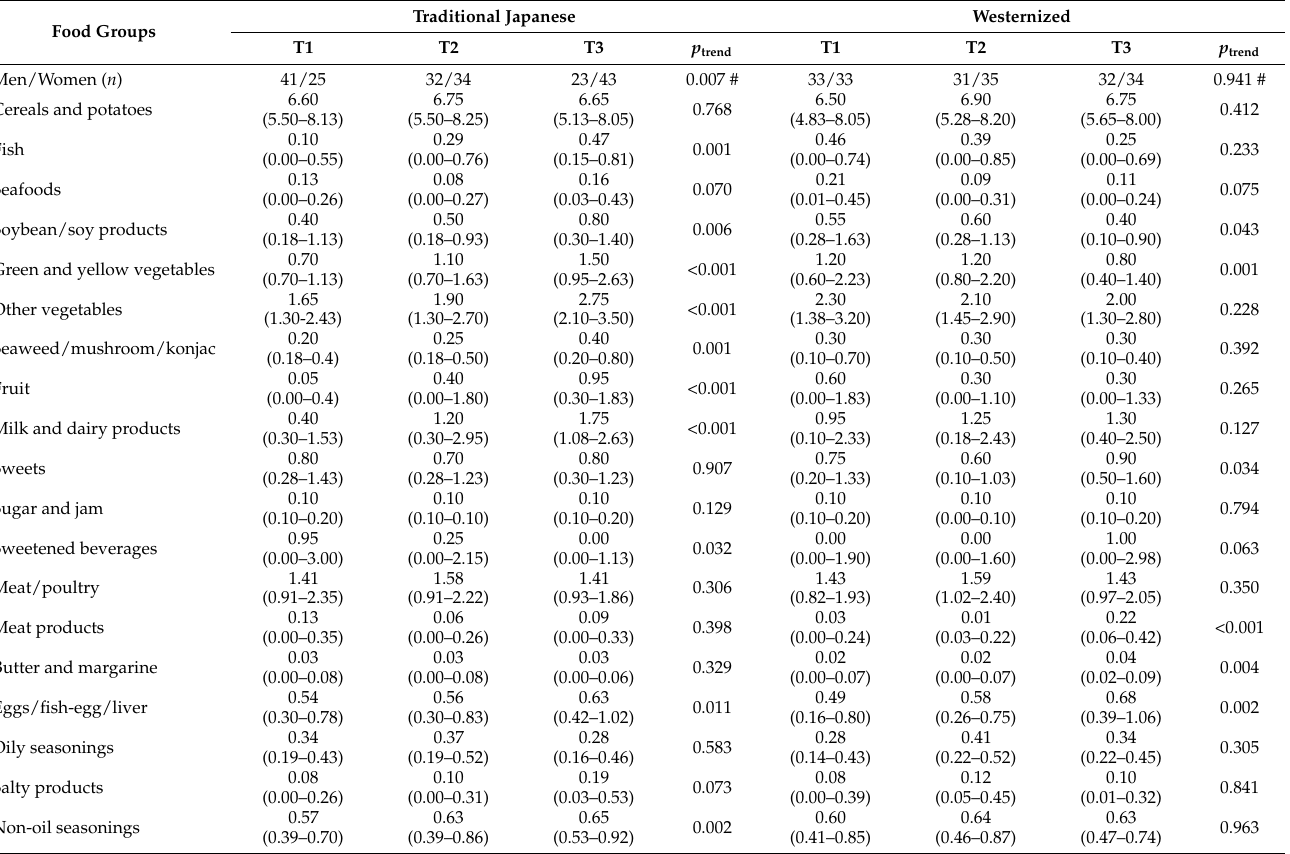
Table 3. Food intakes according to tertiles of the two food intake pattern